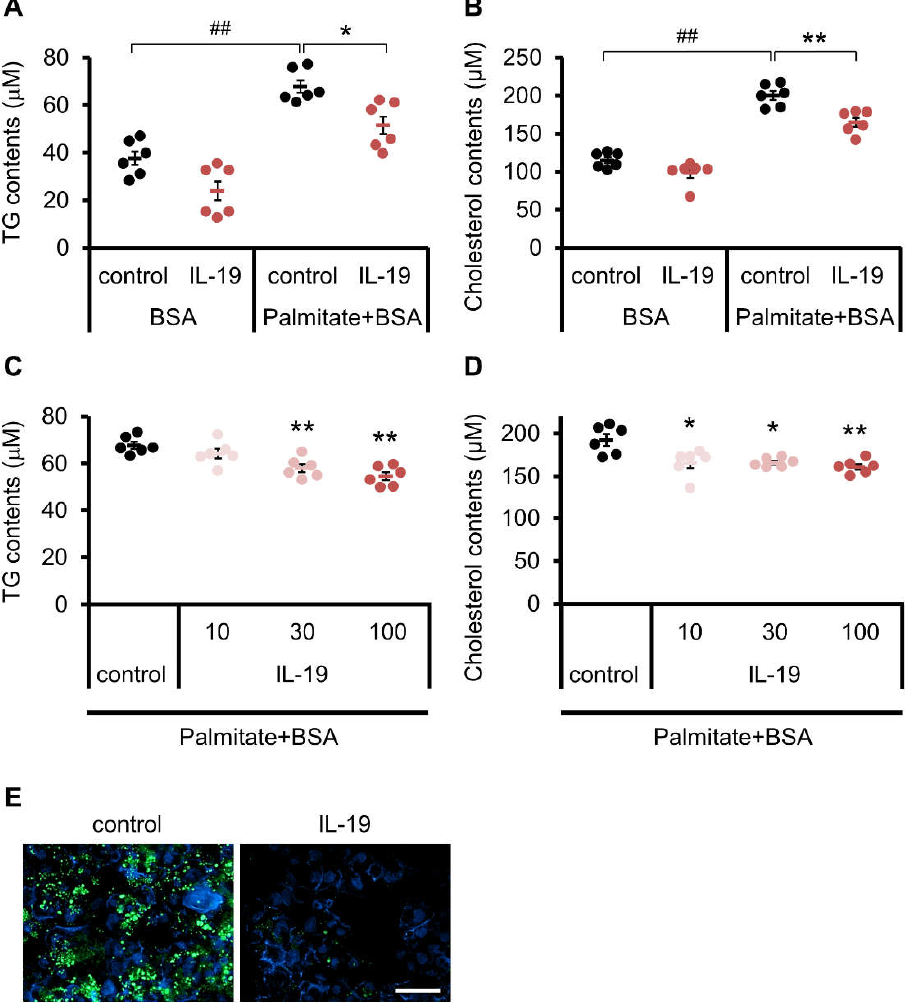
Figure 5. The changes in TG and cholesterol contents. ( A , B , E ) HepG2 cells were treated with 200 µ M palmitate-BSA and 100 ng/mL IL-19 for 48 h. ( C , D ) HepG2 cells were treated with 200 µ M palmitate-BSA and IL-19 for 48 h. ( A , C ) The TG levels were measured ( n = 6). ( B , D ) The cholesterol levels were measured ( n = 6). ( E ) Intracellular TG were visualized by BODIPY (493/503). Representative images are shown ( n = 3). Scale bar represents 50 µ m. ## p < 0.01 vs. BSA. * p < 0.05, ** p < 0.01 vs. control.